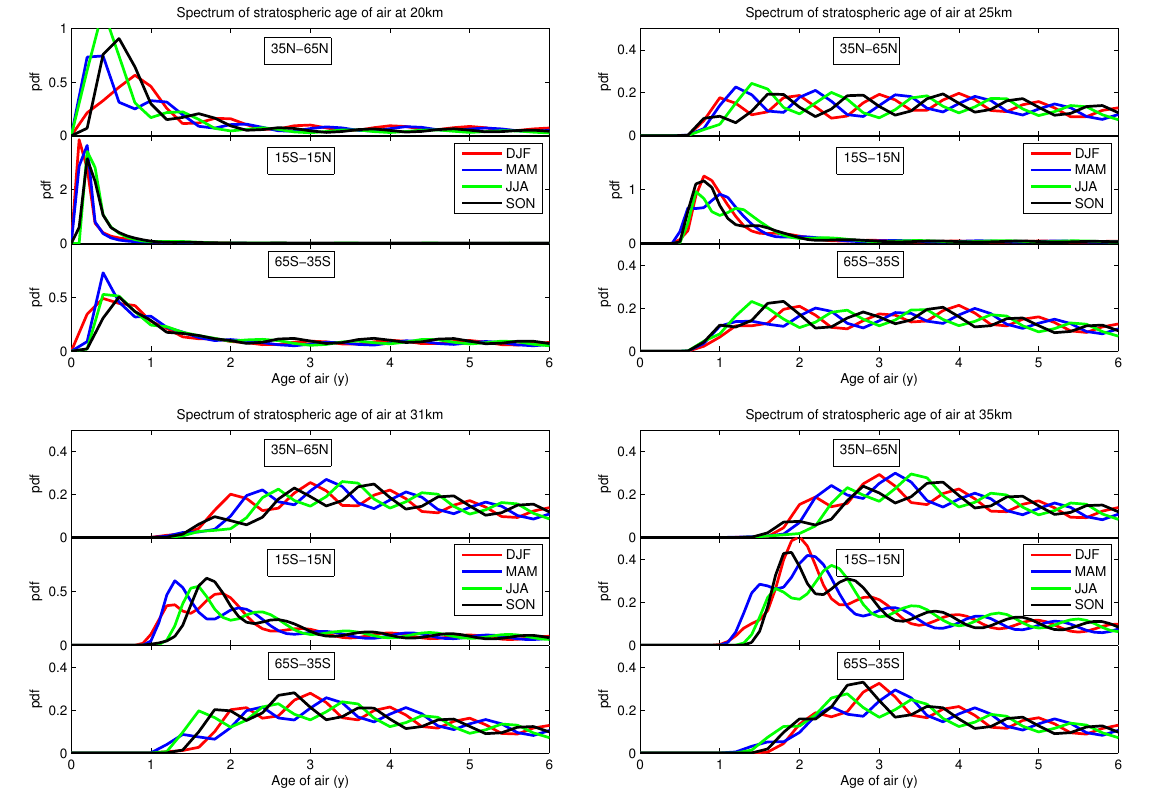
Fig. 7. Age spectra calculated with diabatic trajectories at three altitudes and over three latitude bands. The altitudes are 20km (upper left), 25km (upper right), 31km (lower left) and 35km (lower right). Each panel shows three latitude ranges: 35 ◦ N–65 ◦ N (top), 15 ◦ S–15 ◦ N (mid) and 65 ◦ S–35 ◦ S (bottom). (Red): winter (DJF) age spectrum averaged over 1989–2010. (Blue): spring (MAM) age spectrum. (Green): summer (JJA) age spectrum. (Black): automn (SON) age spectrum.